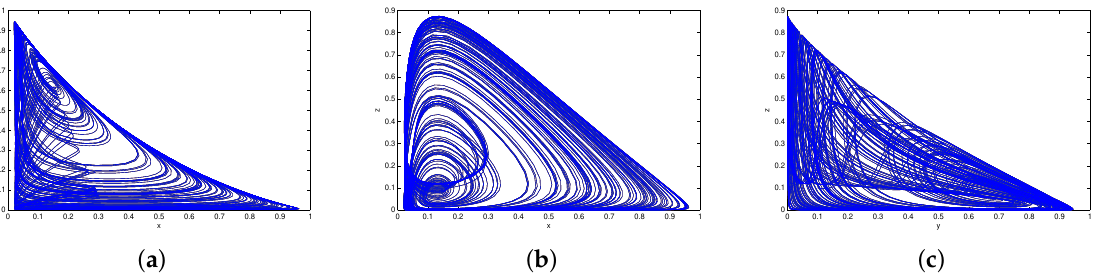
Figure 2. The time series for system (2) with x 0 = 0.1, y 0 = 0.1, z 0 = 0.1 and parameter values r 2 = 0.6, r 3 = 4.5, a 12 = 1, a 21 = 1.5, a 13 = 2.5, a 31 = 0.2, k 3 = 1, d 3 = 0.5.